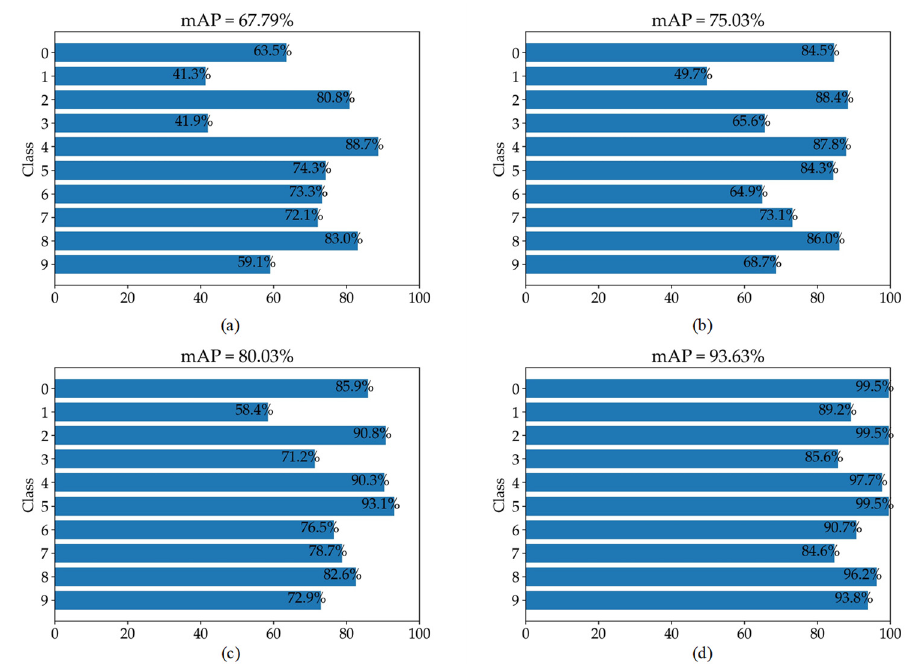
Figure 13. mAP comparison results for only numbers (0–9) on the Greek vehicle dataset for scale factor ( × 4). ( a – d ) represent the mAP results on bicubic results, HIFA-LPR (Step 1) results, HIFA-LPR (Step 2) results, and HIFA-LPR (Step 3), respectively.